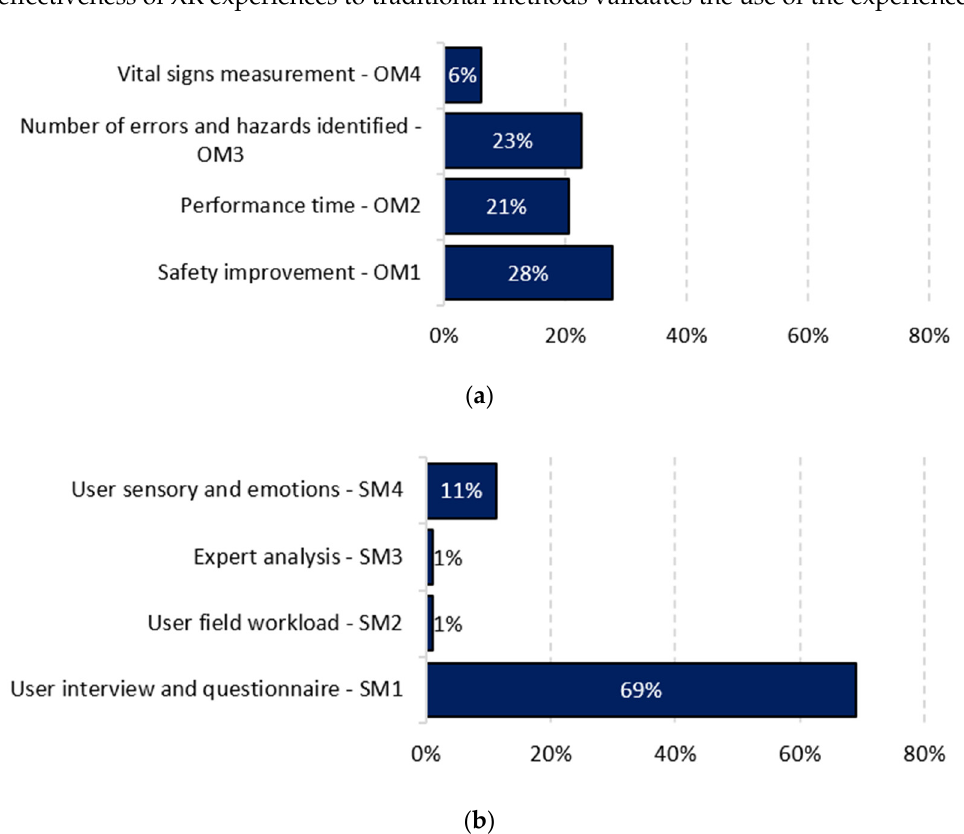
Figure 14. Types of evaluation. ( a ) Objective methods; ( b ) Subjective methods.